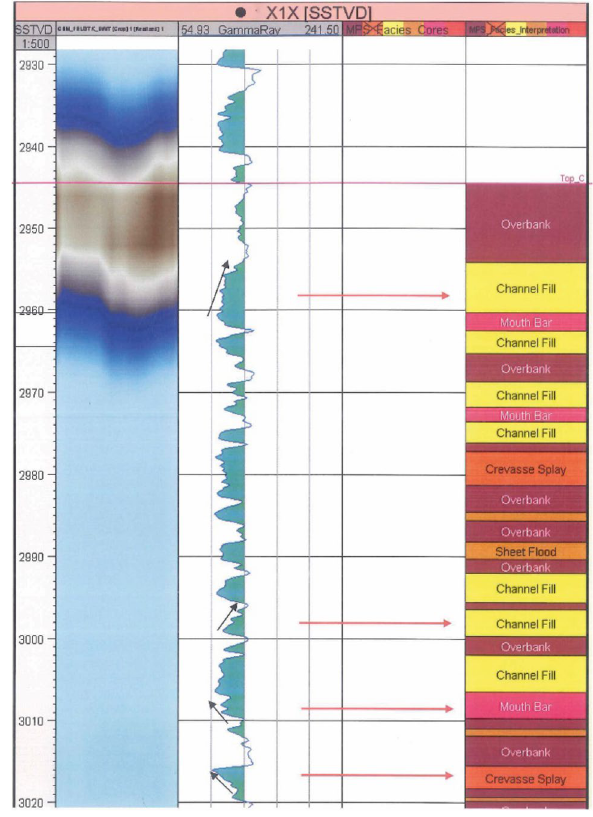
Fig. 8 Facies interpretation result in 4X-based gamma ray